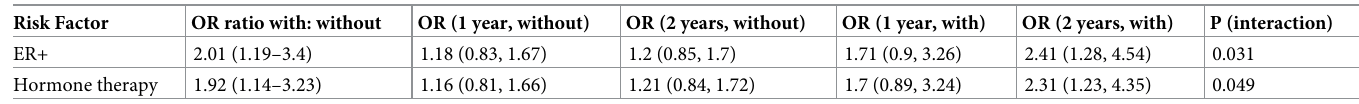
Table 2. Subgroup-specific effect of trastuzumab (taken for 1 or 2 years) on the risk of nausea is shown for each subgroup as an odds ratio, along with the ratio of odds ratios between subgroups with and without the given risk factor. 291 patients out of the 5,000 in the trial suffered nausea. Risk Factor OR ratio with: without OR (1 year, without) OR (2 years, without) OR (1 year, with) OR (2 years, with) P (interaction) Hormone